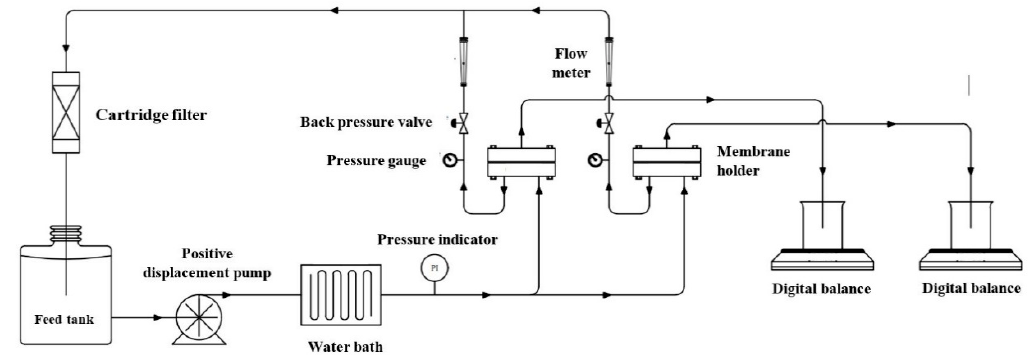
Figure 1. The experimental arrangement used for the reverse osmosis (RO) experiments.